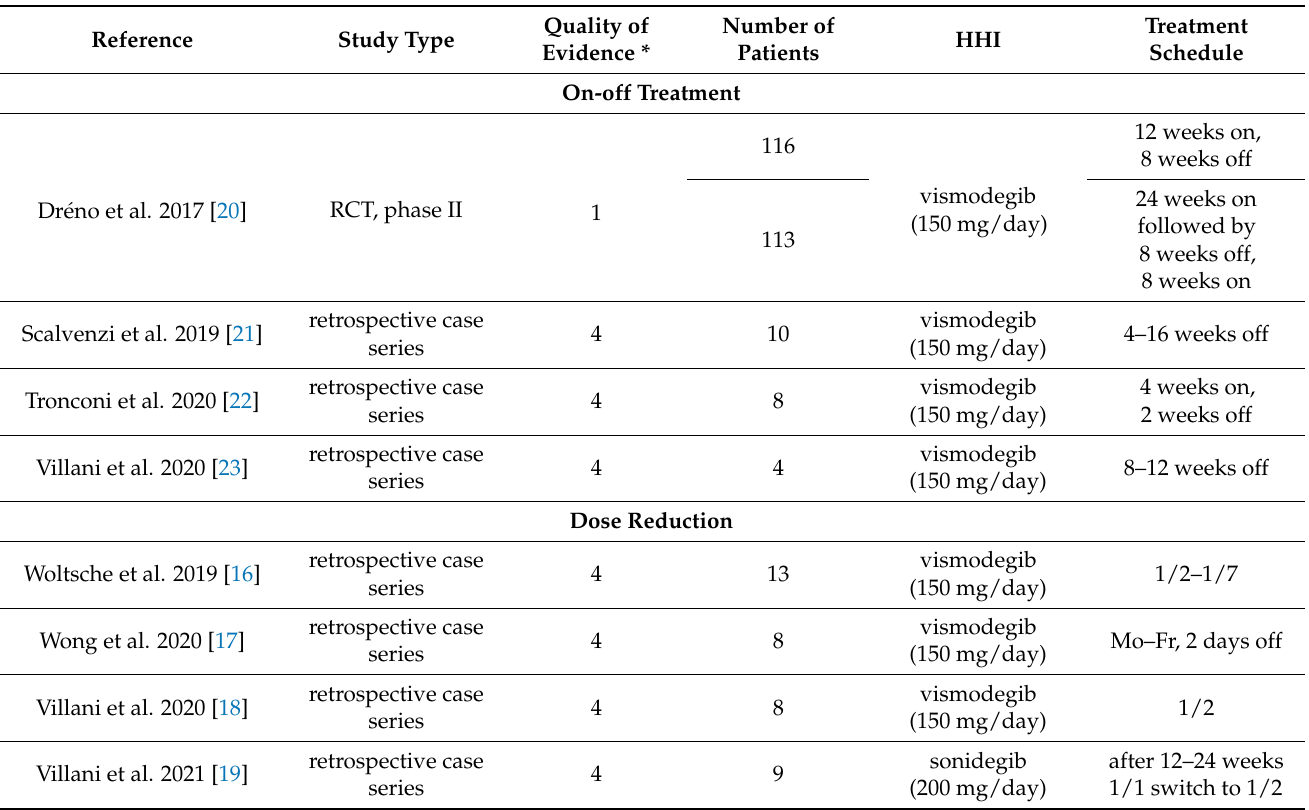
Table 3. Overview of published alternative dosing regimens of HHIs that showed improved tolera- bility while maintaining